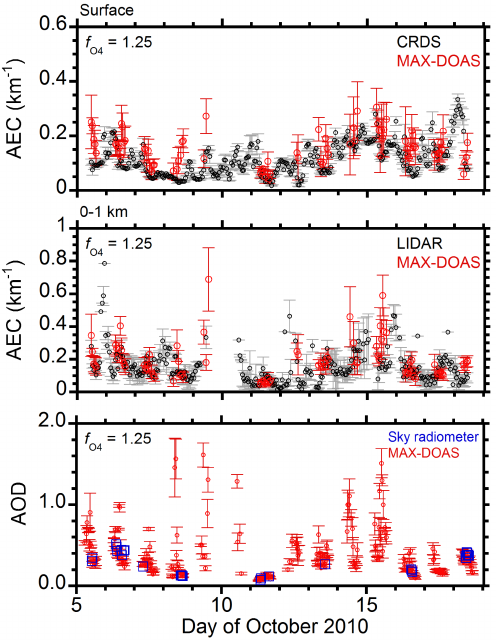
Figure 4. Time series of AEC and AOD values at 476nm on 5–18 October 2010. (Top) Near-surface AEC values from CRDS and MAX-DOAS; (middle) AEC values for 0–1km from lidar and MAX-DOAS; (bottom) AOD values from sky radiometer and MAX-DOAS are compared in respective plots. For the MAX- DOAS retrieval, a f O of 1.25 is assumed. Error bars for MAX- 4 DOAS represent uncertainty associated with the retrieval. Error bars for CRDS represent the 1 σ values estimated from the uncertainties in the AEC measurements at 355 and 532 nm and in the corrections for RH and wavelength dependence. Error bars for lidar represent 1 σ standard deviations of original 30m AEC values in the 0–1km